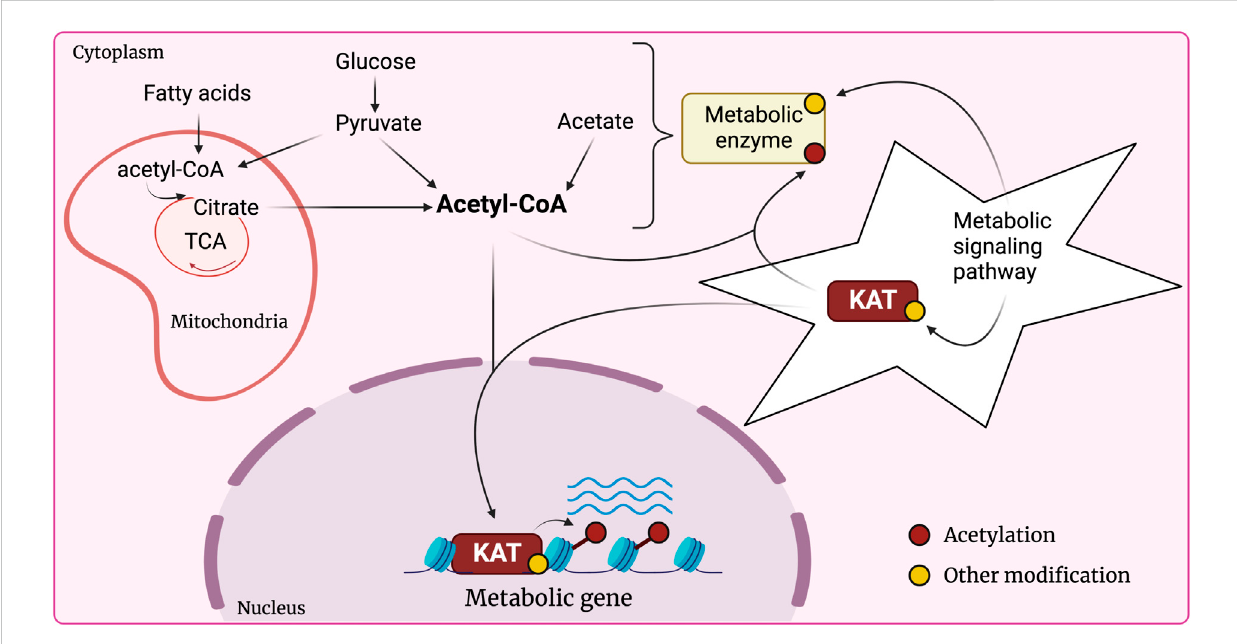
FIGURE 1 KATs at the nexus of crosstalk between chromatin modi fi cation and metabolism. Glucoseand fatty acids constitute the main source of cytoplasmic acetyl-CoA, where pyruvate (product of glycolysis) and fatty acids enter the mitochondria to produce acetyl-CoA which feeds into the tricarboxylic acid (TCA) cycle and produces citrate. Citrate is then transported to the cytoplasm where it can yield acetyl-CoA. Other sources include acetate or direct conversion of cytoplasmic pyruvate into acetyl-CoA. The pool of acetyl-CoA available for KAT activity is sensitive to fl uctuations in